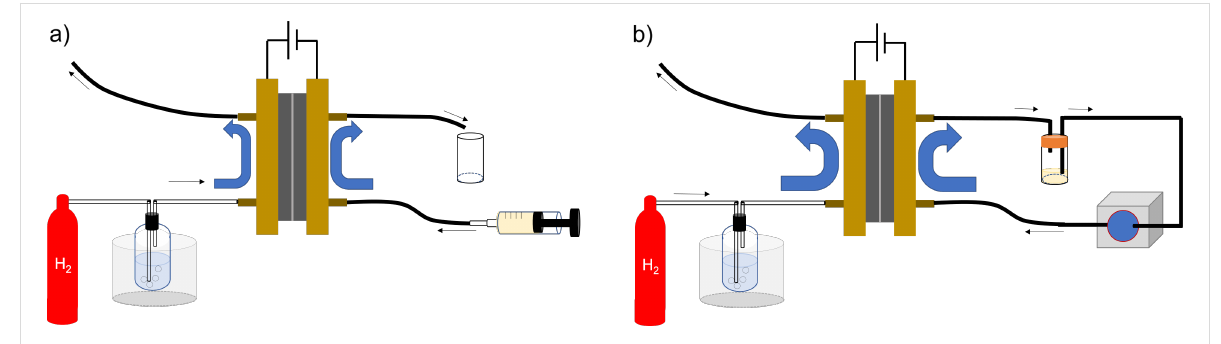
Figure 1: Electrochemical setup of the PEM reactor: a) Electrochemical reduction system with the PEM reactor. b) Circulating electrochemical reduc- tion system with the PEM